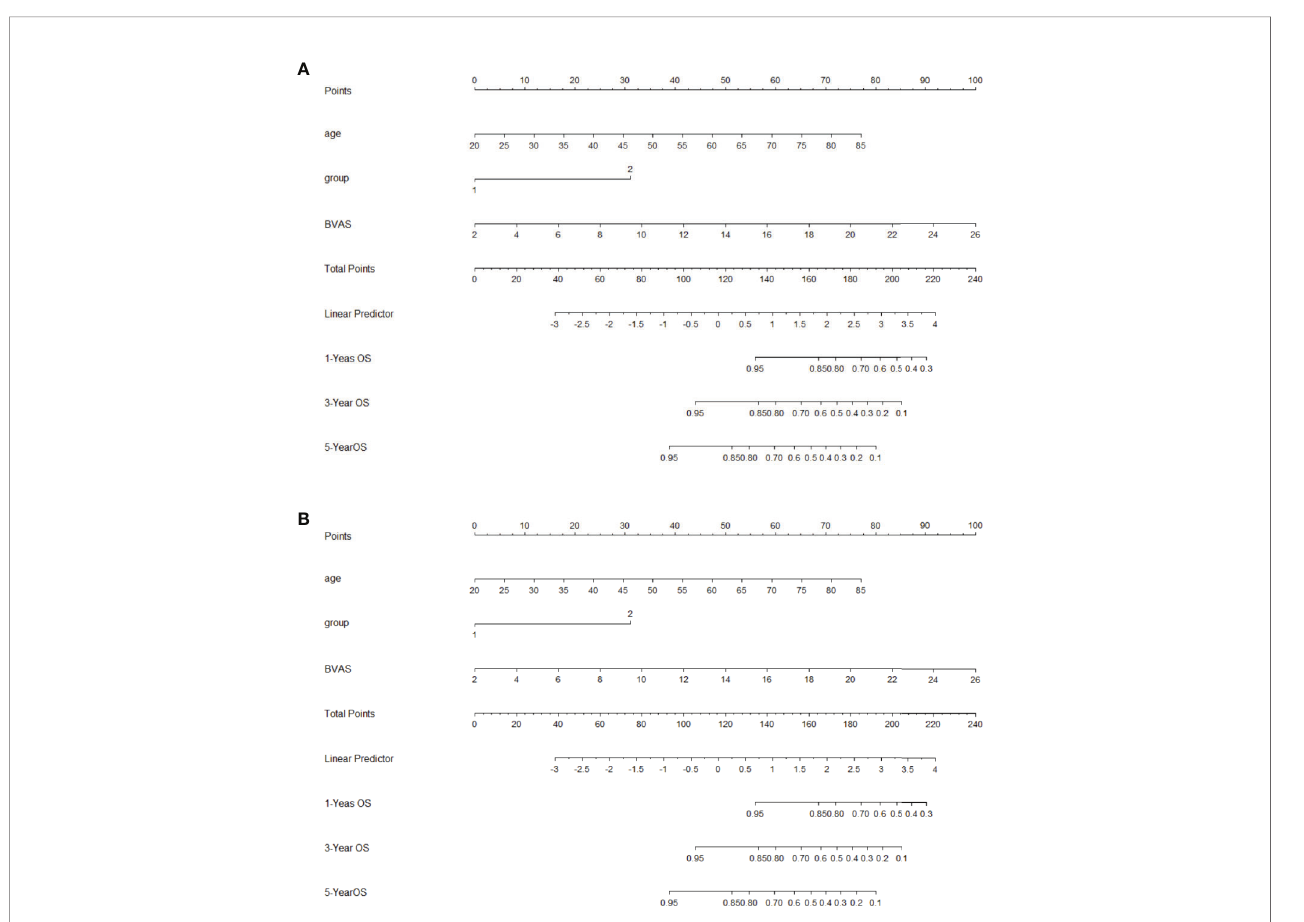
FIGURE 2 | Nomograms for outcomes (A) , nomogram for renal outcome; (B) , nomogram for survival outcome; To use the nomogram, based on patient ’ s value, draw upward lines from each variable axis to the points, and calculate the sum of these points. And draw a downward line from total point axis to the survival axis to get the likelihood of 1-, 3-, 5-year